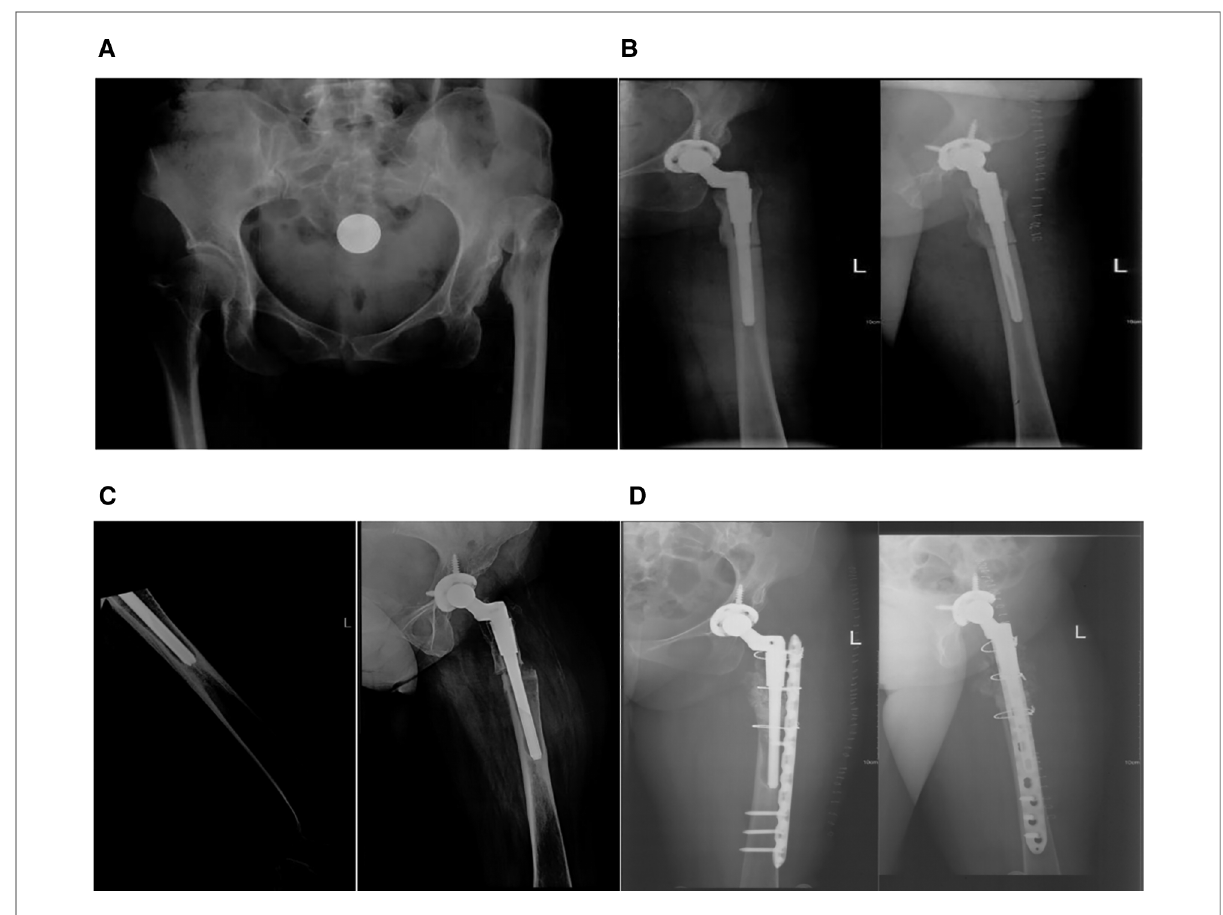
FIGURE 2 ( A ): anteroposterior pelvic x-ray with a diagnosis of left crowe IV DDH (left). ( B ): x-ray of initial subtrochanteric osteotomy with S-ROM prosthesis replacement. ( C ): After the patient fell, the distal end of the S-ROM prosthesis became loose, ( D ): x-ray of the left femur after revision of the left hip